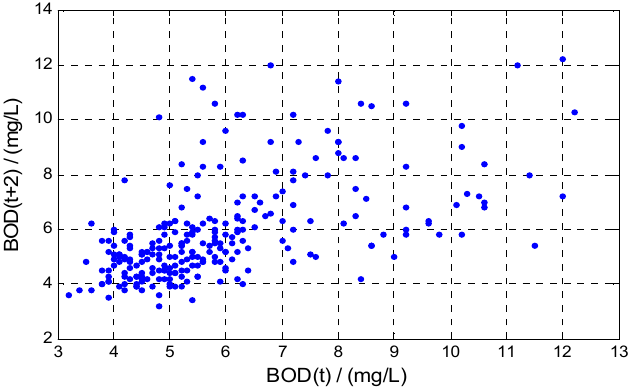
Figure 7. Two ‐ dimension phase space portrait of BOD dataset. Figure 7. Two-dimension phase space portrait of BOD